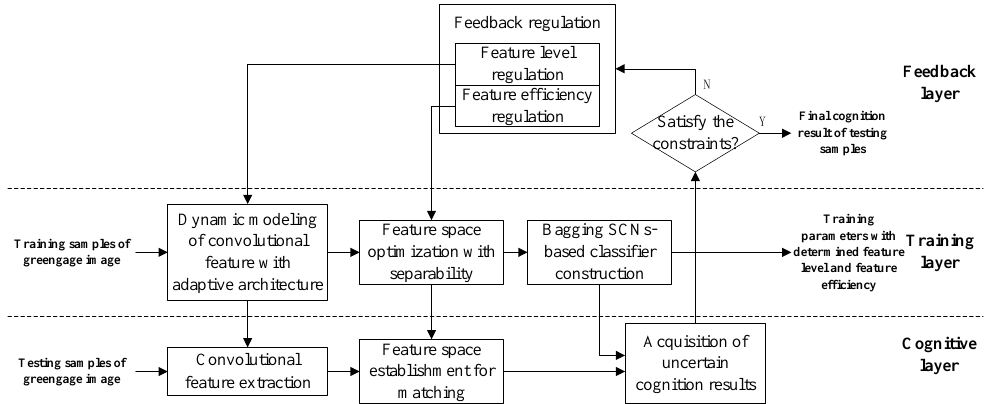
Figure 1. The cognitive model for greengage grading based on dynamic feature and ensemble net-